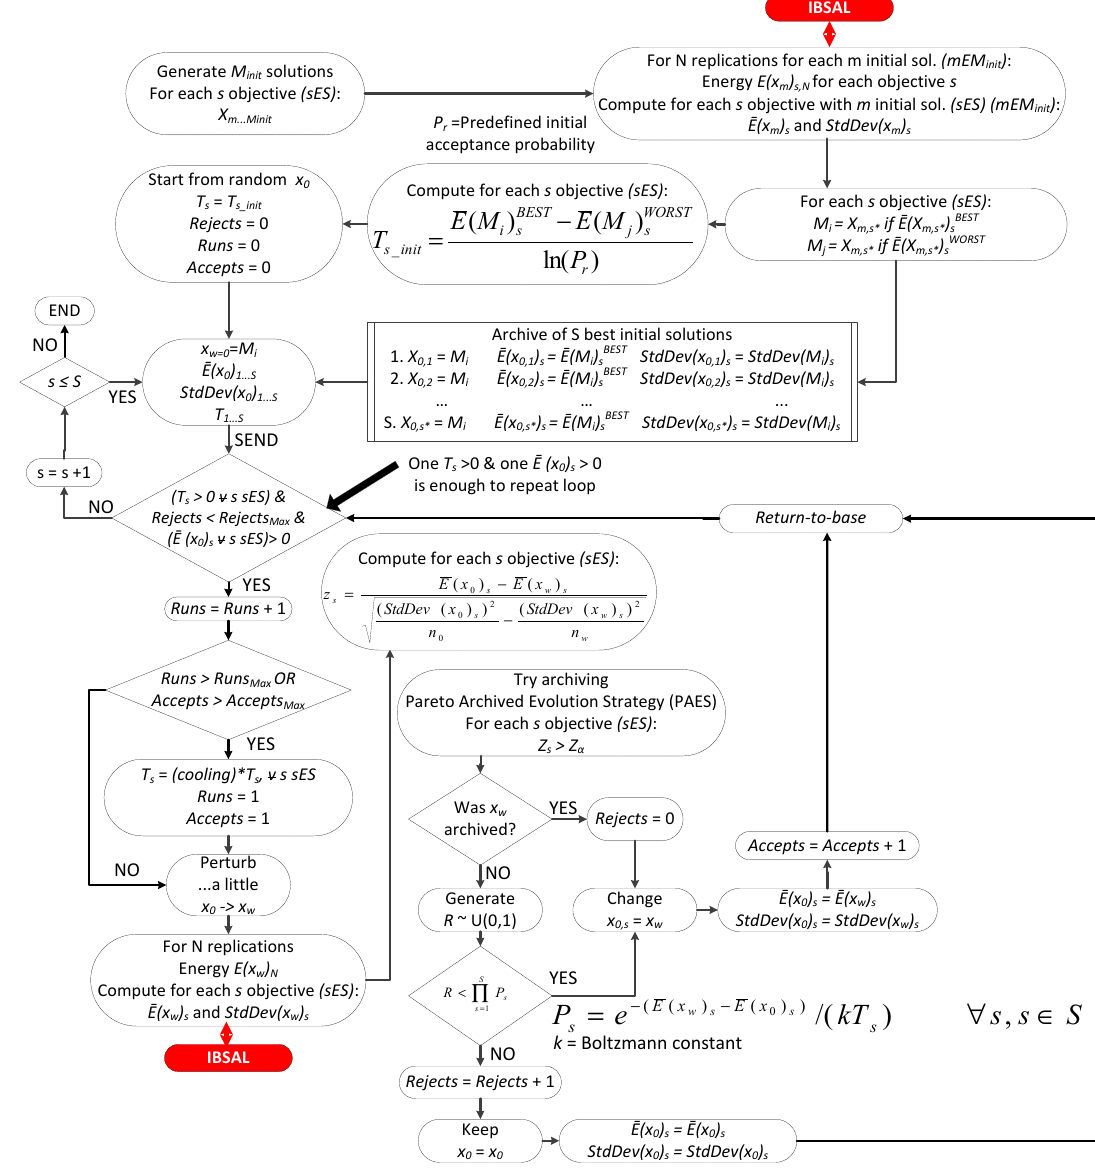
Figure 2. SimMOpt optimization method.